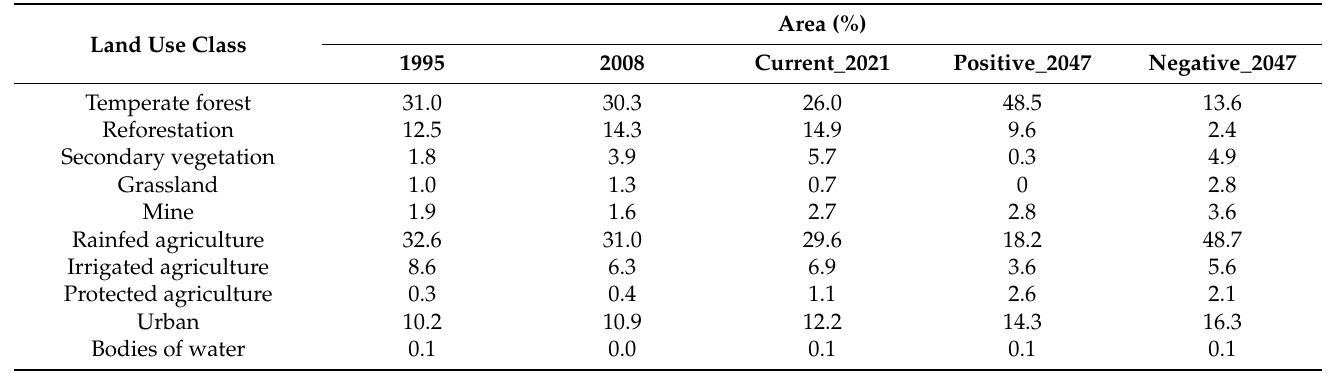
Table 6. Area (%) of land use in 1995 and 2008 and scenarios 2021 and